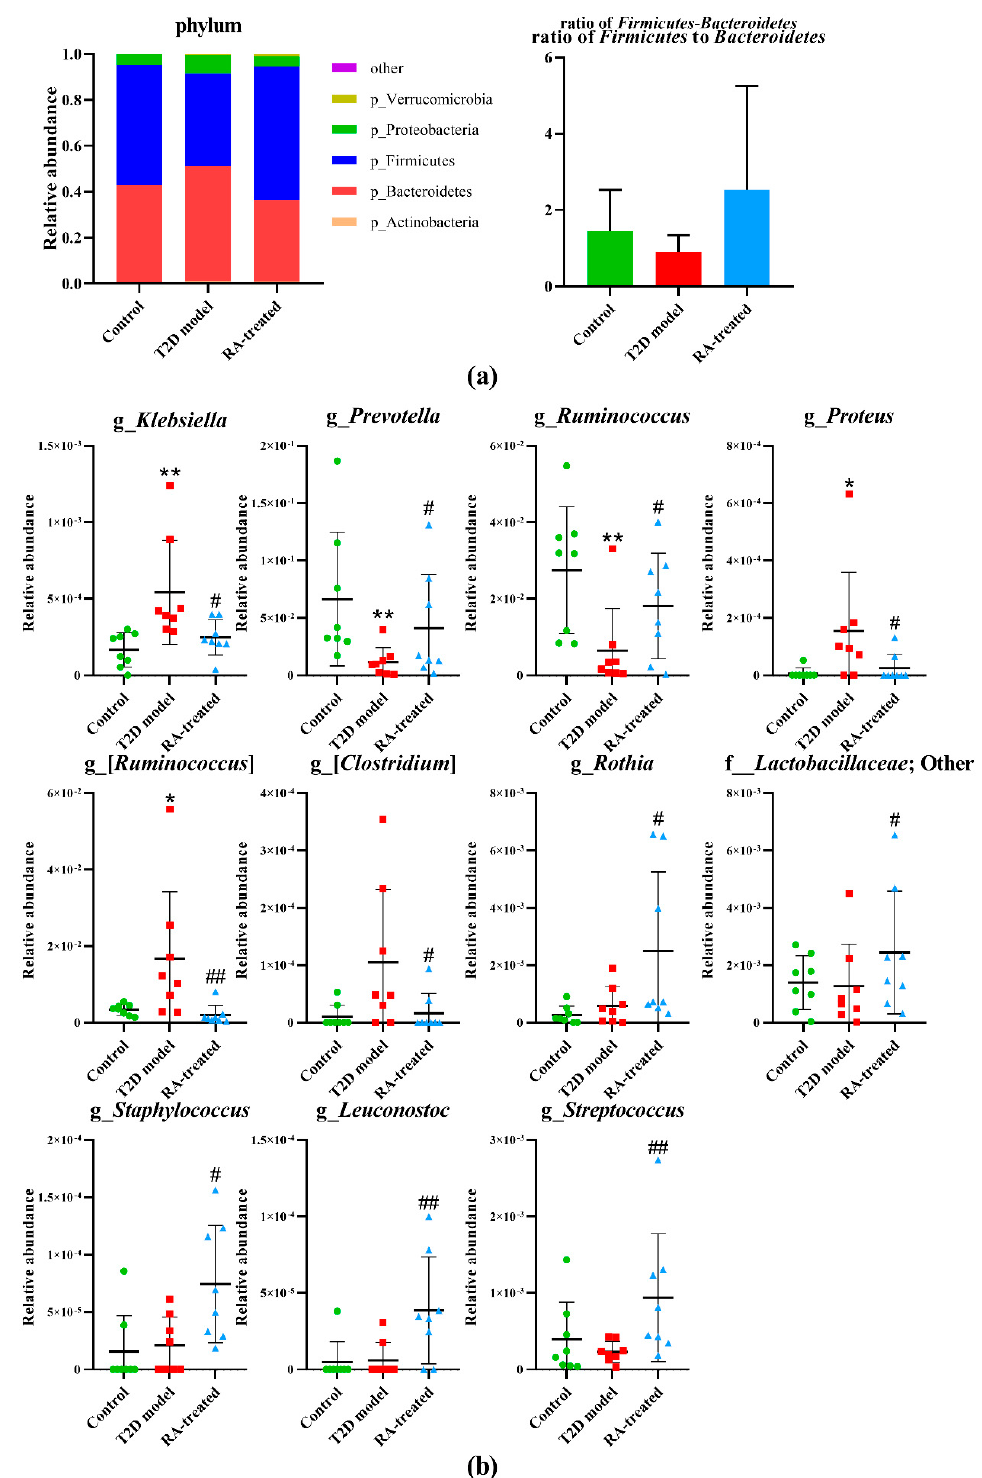
Figure 4. ( a ) Composition analysis of gut microbiota at the phylum level in the control, T2D model and RA-treated groups. ( b ) Relative abundances of gut microbiota at the genus level in the control, T2D model and RA-treated groups. * p < 0.05 vs. control group; ** p < 0.01 vs. control group; # p < 0.05 vs. T2D model group; ## p < 0.01 vs. T2D model group by Mann–Whitney U rank sum test.